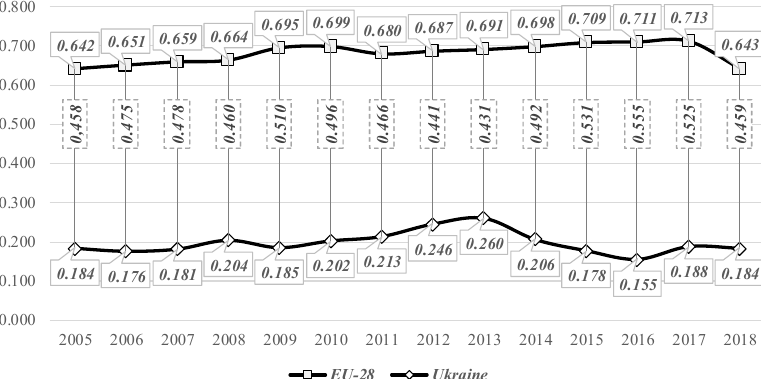
Fig. 4. Integral indices and gaps of fluctuations of social and economic development of Ukraine and the EU-28, 2005-2018